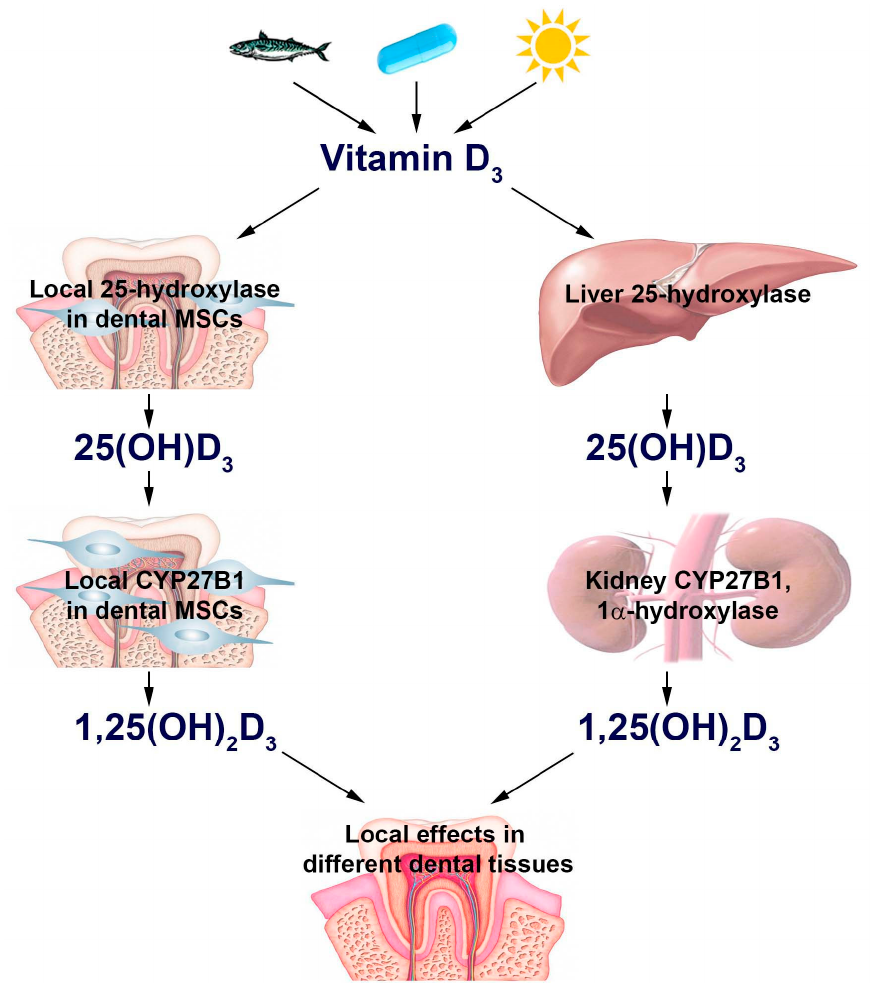
Figure 1. Systemic and local vitamin D 3 metabolism.